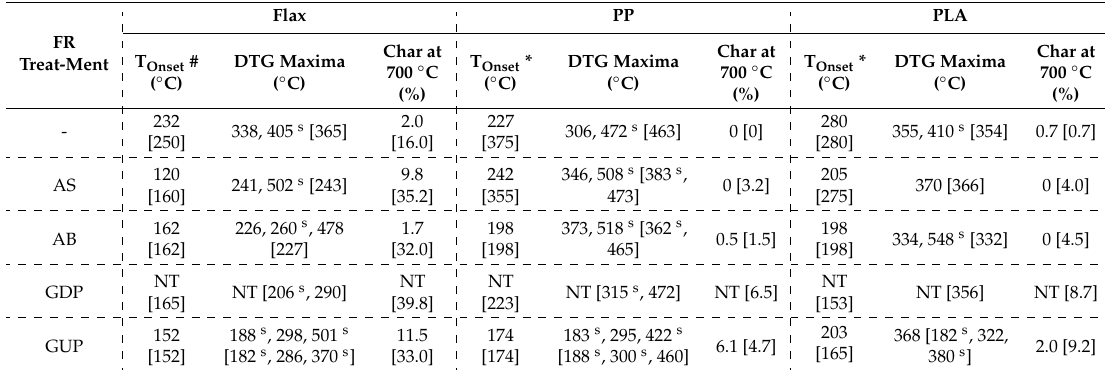
Figure 4. ( a ) PCFC and ( b ) TGA curves in air and nitrogen of PP, PLA, flax, flax / PP, and flax / PLA. Table 5. TGA, and DTG results of unmodified and fire retarded Flax, PP, PLA, Flax / PP, and Flax / PLA fibres in air and nitrogen (given in